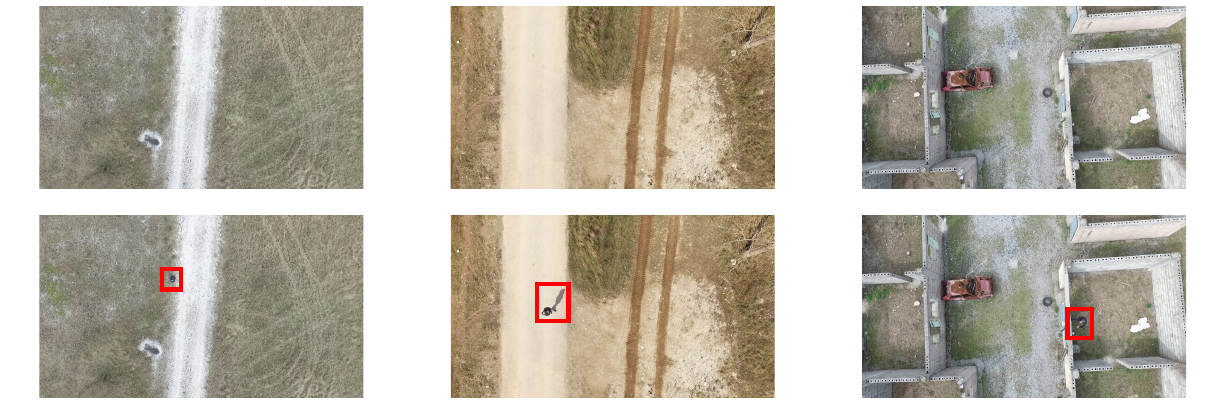
Figure 4. Image samples for different environments in the UMCD Dataset. In the first row, images associated to the normal state. In the second row, the same images presenting anomalies, highlighted in the red bounding